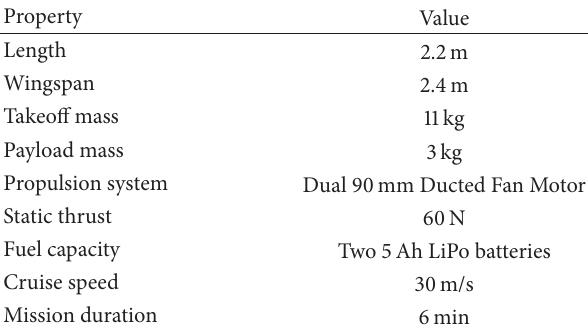
Table 1: Details for WVU Phastball aircraft.